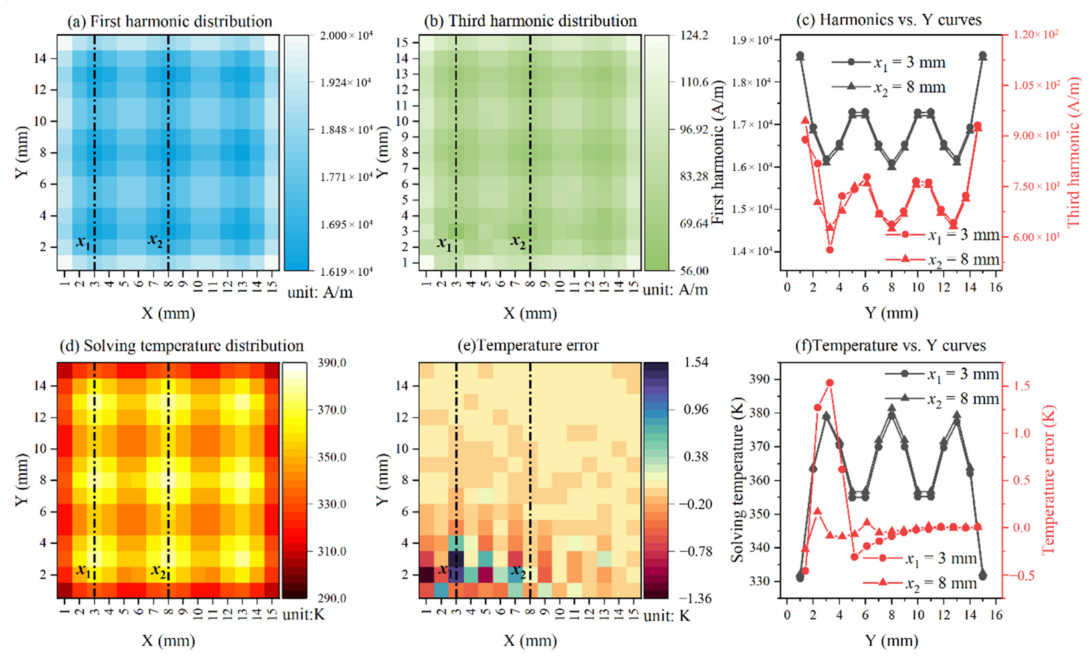
Figure 3. ( a ) First harmonic distribution of magnetic nanoparticles on each pixel point found using deconvolution algorithm. ( b ) Third harmonic distribution of magnetic nanoparticles on each pixel point was found using deconvolution algorithm. ( c ) The harmonics versus Y curves along the white dashed lines ( x 1 = 3 mm and x 2 = 8 mm). ( d ) The solving temperature distribution of 2-D imaging area coated with MNPs. ( e ) The temperature error compared to the setting temperature. ( f ) The temperature versus Y curves along the white dashed lines ( x 1 = 3 mm and x 2 = 8